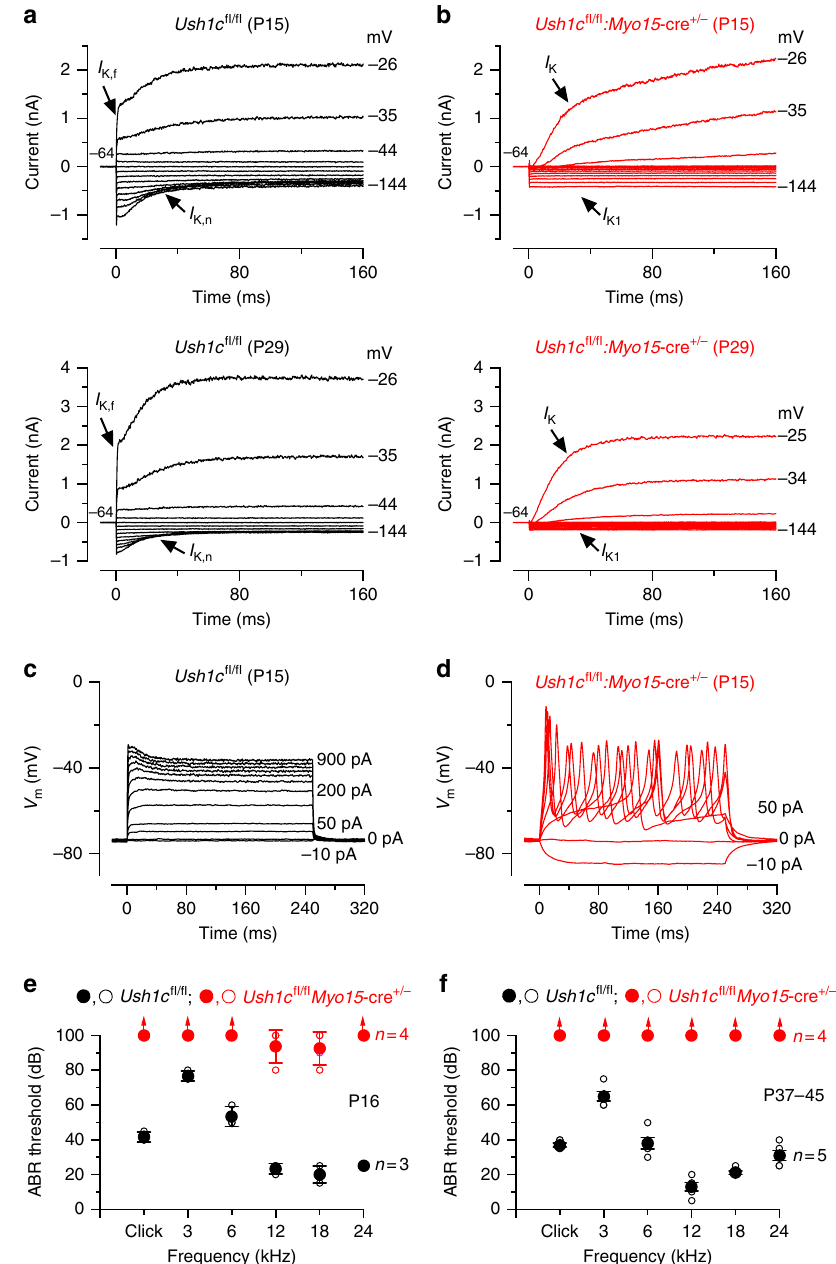
Fig. 3 IHCs from Ush1c fl / fl Myo15 -cre + /- conditional knockout mice fail to mature. a , b Potassium currents recorded from P15 (upper panels) and P29 (lower panels) IHCs from control Ush1c fl / fl ( a ) and Ush1c fl / fl Myo15 -cre + /- ( b ) mice using 10 mV depolarizing and hyperpolarizing voltage steps from − 64 mV. Note that the K + currents characteristic of adult IHCs ( I K,f and I K,n ) were only present in IHCs from control Ush1c fl / fl mice ( a ). IHCs from Ush1c fl / fl Myo15 -cre + /- mice retained the K + currents characteristic of pre-hearing stages ( I K and I K1 ). c , d Voltage responses elicited by applying hyperpolarizing and depolarizing current injections from the respective membrane potentials in P15 IHCs of control Ush1c fl / fl ( c ) and Ush1c fl / fl Myo15 -cre + /- ( d ) mice. Note that APs are still present in post-hearing Ush1c fl / fl Myo15 -cre + /- IHCs. For more details see Supplementary Table 2. e , f Mean ABR thresholds ( ±SD) for clicks and pure tone stimulation from 3 kHz to 24 kHz obtained from control Ush1c fl / fl and littermate Ush1c fl / fl Myo15 -cre + /- mice at P16 ( e ) and P37-45 ( f ). Ush1c fl / fl Myo15 -cre + /- mice are almost completely deaf already at P16. Open symbols represent data from single mice. Closed symbols represent averages (mean ±